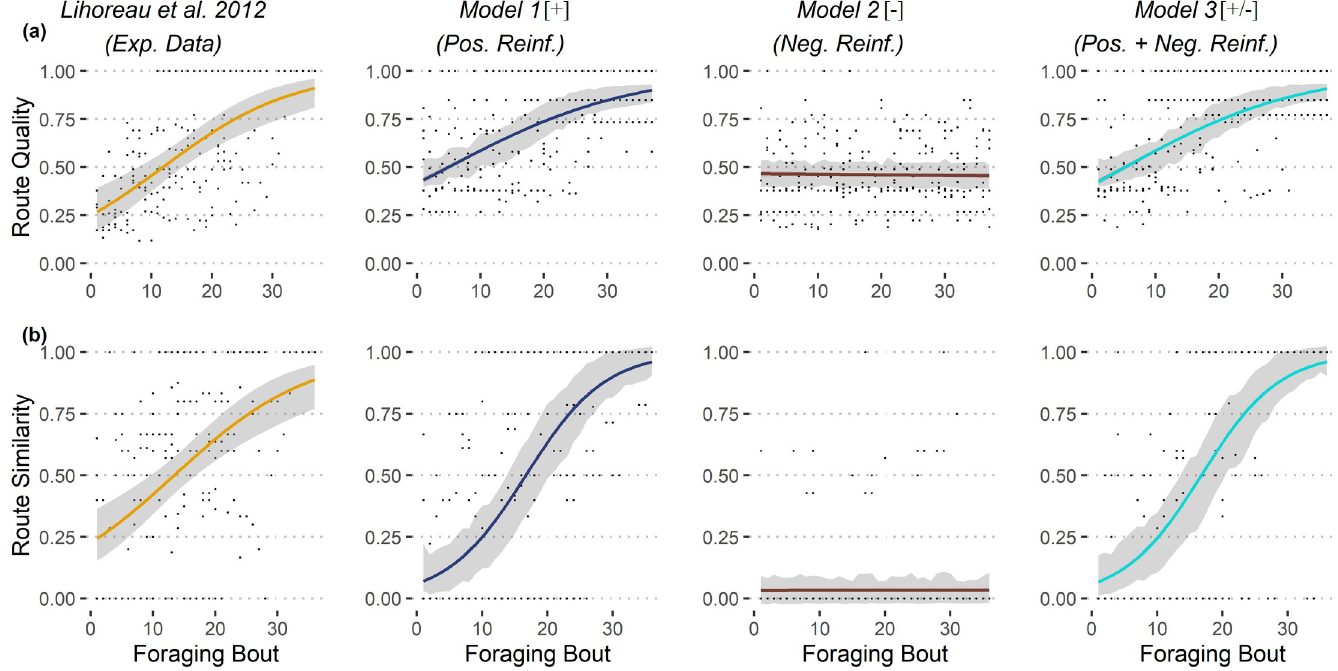
Fig 2. Comparisons of experimental and simulated route qualities. Comparisons of route qualities (a) and route similarities (b) between simulations and experimental data (regular pentagonal array of flowers as in [22]). See details of models in Fig 1. For each dataset, we show the estimated average trends across foraging bouts (coloured curves), along the standard error (grey areas) of the mean. For the sake of eye comparison, in the simulation plots the standard error of the mean is estimated from a sample of 7 simulations (N = 7 bees in [22]). Average trends were estimated over 500 simulation runs, using GLMM Binomial model with bee identity as random effect (bee identity nested in simulation identity for simulated